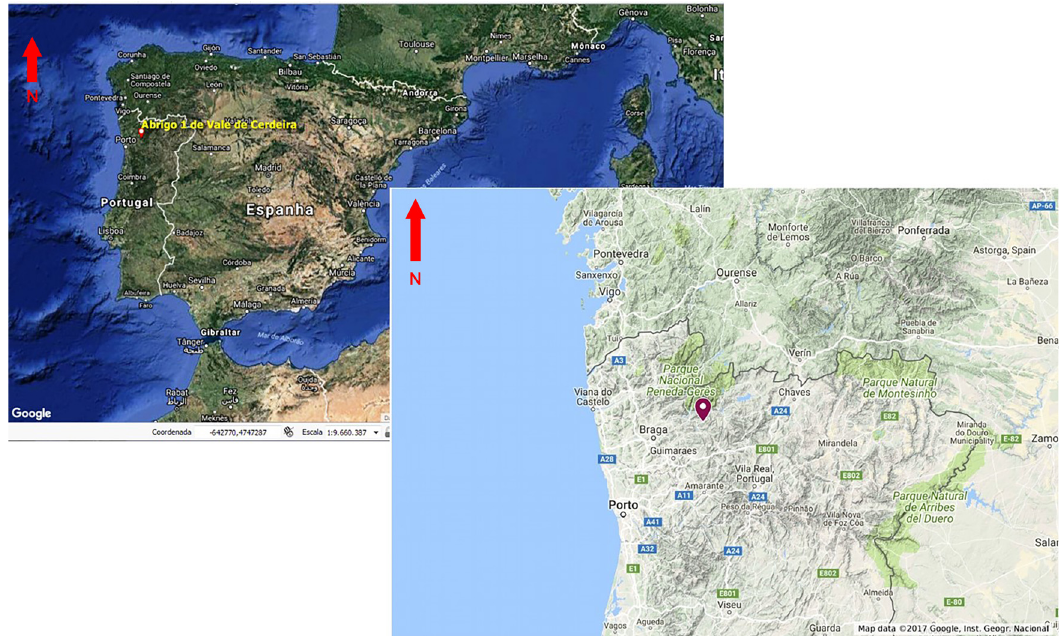
Figure 1: Location of “ Rock Shelter 1 of Vale de Cerdeira ” archaeological